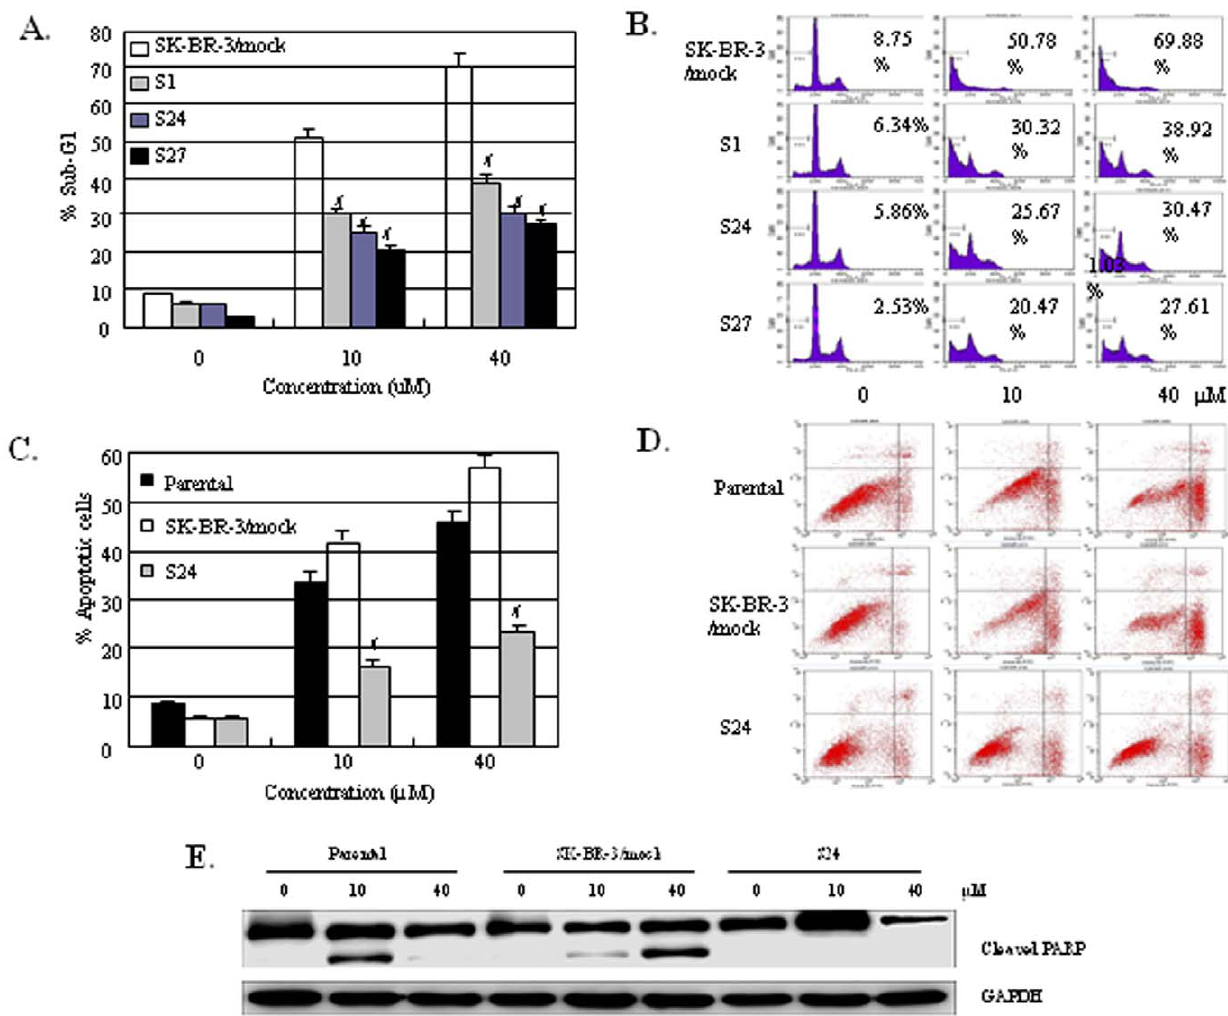
Figure 3. Overexpression of Lin28 decreases the paclitaxel-induced apoptosis in SK-BR-3 cell lines stably expressing Lin28. Cells were treated with paclitaxel at doses ranging from 0 to 40 m M for 48 h, and apoptosis was analyzed. The empty vector-transfected cells were used as controls. ( A ). Sub-G1 peak compared with control in SK-BR-3 lin28 stable expression clones # , P , 0.01. ( B ). Representative of PI staining examined in SK-BR-3 lin28 stable expression clones. ( C ). Apoptosis compared with control in SK-BR-3 lin28 stable expression S24 clone. # , P , 0.01. ( D ). Representative of PI-Annexin d examined in S24 clone. ( E ) PARP expression was determined in indicated cells by Western blotting.